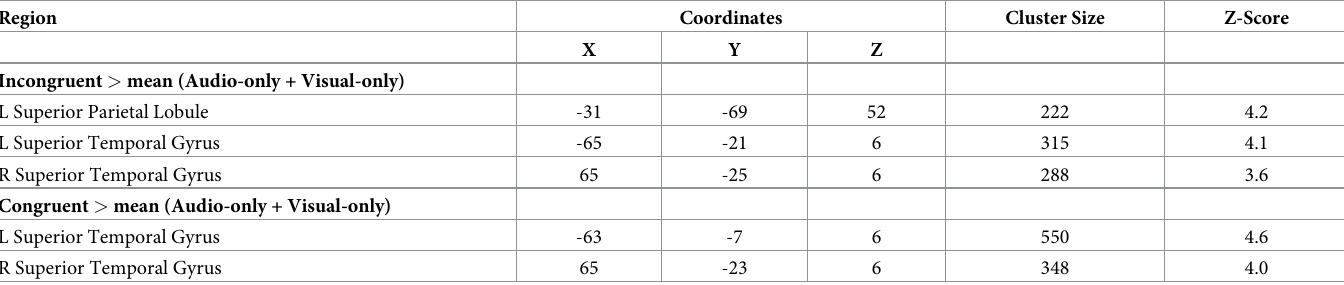
(19) = 4.1, p < 0.001), and audio-only greater than visual-only trials ( t (19) = 6.1, p < 0.001). The posterior STG region also exhibited greater activation for the audio-only trials than for the AV congruent trials, indicating a facilitation effect due to the congruent visual stimulus ( t (19) = 3.0, p = 0.003). The left anterior STG ROI was more responsive to all of the conditions containing auditory stimuli compared to the visual-only condition (incongruent > visual-only t Table 2. Significant regions and peak coordinates for incongruent and congruent–mean unisensory contrasts in A > 0 regions (all clusters > 10 voxels reported).